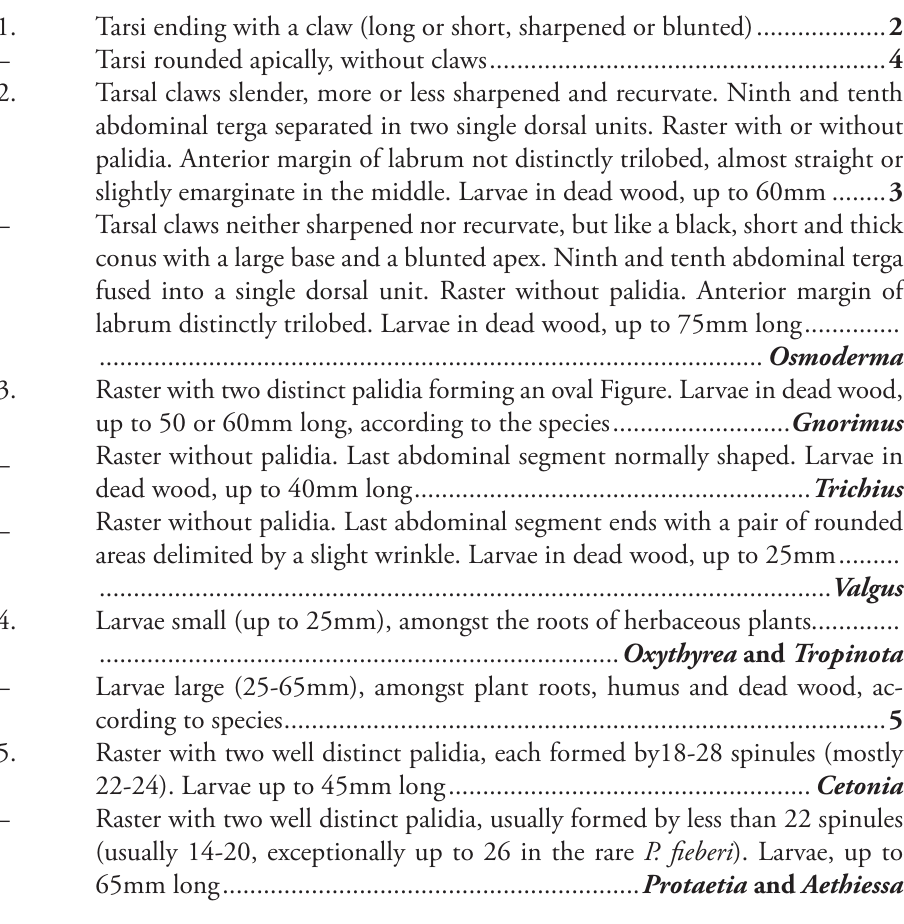
2. Tarsal claws slender, more or less sharpened and recurvate. Ninth and tenth abdominal terga separated in two single dorsal units. Raster with or without palidia. Anterior margin of labrum not distinctly trilobed, almost straight or slightly emarginate in the middle. Larvae in dead wood, up to 60mm ........ 3 – Tarsal claws neither sharpened nor recurvate, but like a black, short and thick conus with a large base and a blunted apex. Ninth and tenth abdominal terga fused into a single dorsal unit. Raster without palidia. Anterior margin of labrum distinctly trilobed. Larvae in dead wood, up to 75mm long .............. ................................................................................................. Osmoderma 3. Raster with two distinct palidia forming an oval Figure. Larvae in dead wood, up to 50 or 60mm long, according to the species .......................... Gnorimus _ Raster without palidia. Last abdominal segment normally shaped. Larvae in dead wood, up to 40mm long .......................................................... Trichius _ Raster without palidia. Last abdominal segment ends with a pair of rounded areas delimited by a slight wrinkle. Larvae in dead wood, up to 25mm ......... ........................................................................................................... Valgus 4. Larvae small (up to 25mm), amongst the roots of herbaceous plants............. ............................................................................ Oxythyrea and Tropinota – Larvae large (25-65mm), amongst plant roots, humus and dead wood, ac- cording to species ........................................................................................ 5 5. Raster with two well distinct palidia, each formed by18-28 spinules (mostly – Raster with two well distinct palidia, usually formed by less than 22 spinules (usually 14-20, exceptionally up to 26 in the rare P. fieberi ). Larvae, up to